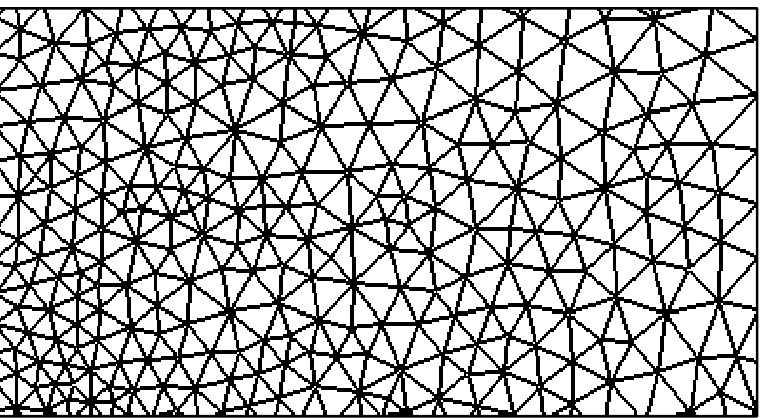
Figure 3. The unstructured mesh views in the channel middle.